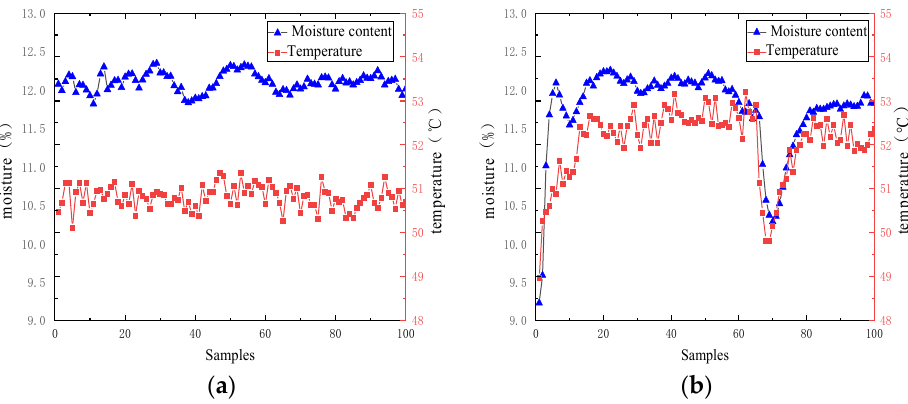
Figure 8. Moisture and temperature at the outlet of the oven: ( a ) Optimization algorithm; ( b ) manual control.